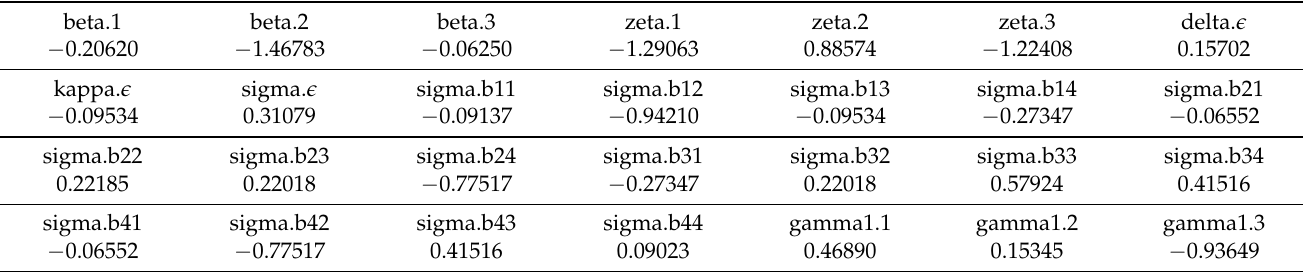
Figure 2. Trace plots ( a ), autocorrelation plots ( b ) and BGR convergence statistic plots ( c ) of some representative parameters from the chosen model. The trace plots show how well the chains are mixed. The BGR statistic plots, which are the ratio (red line) of the pooled within-chain posterior variability (green line) to the average variability across the three chains (blue line), approached to 1.0. In addition, after thinning, the level of autocorrelation drops rapidly as the number of lags increases. Thus, the plots ( a – c ) demonstrate convergence. Table 1. Results of the Geweke’s test of convergence. The computed value of the test statistic for each parameter from the chosen